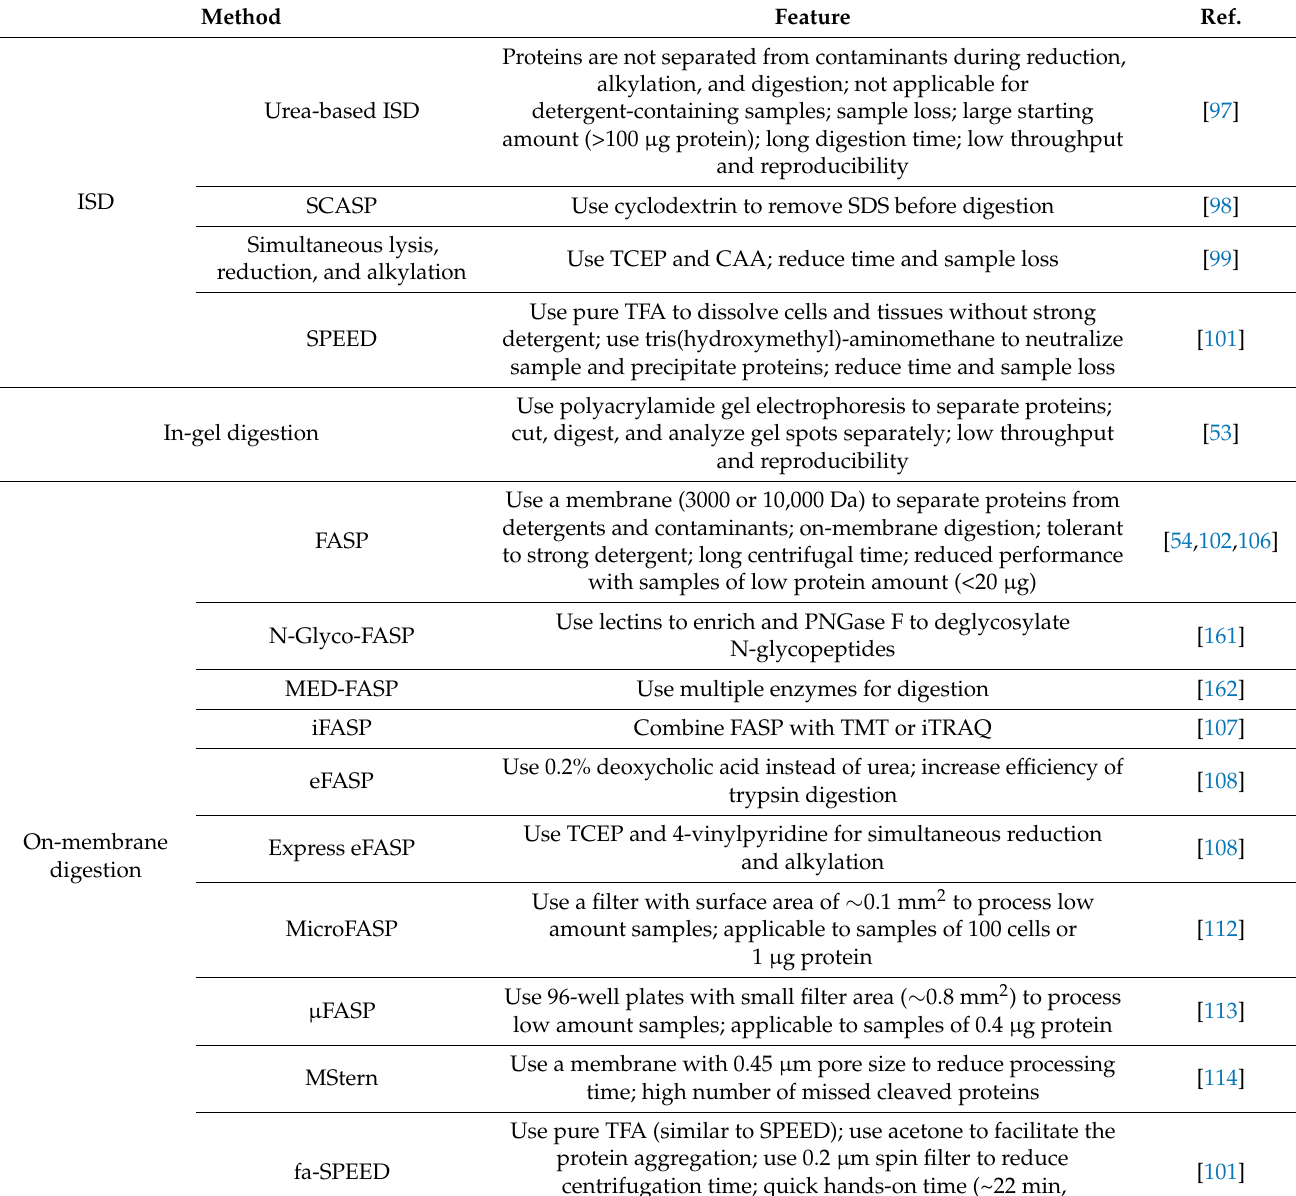
Table 1. Features of different protein digestion